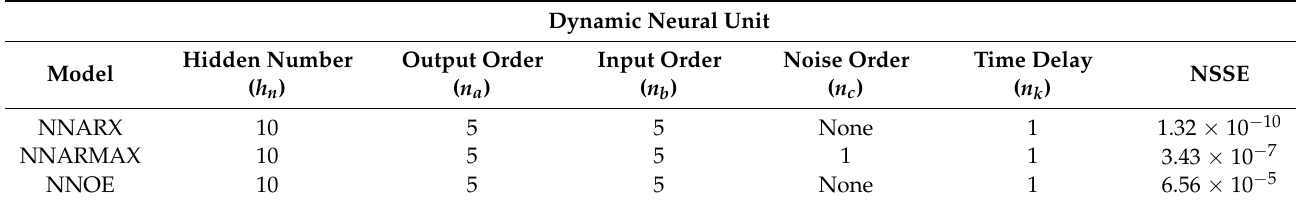
Figure 5. Comparison results of different DNN models convergent iteration. Table 2. The selected repressor parameters and analysis results of DNN models.